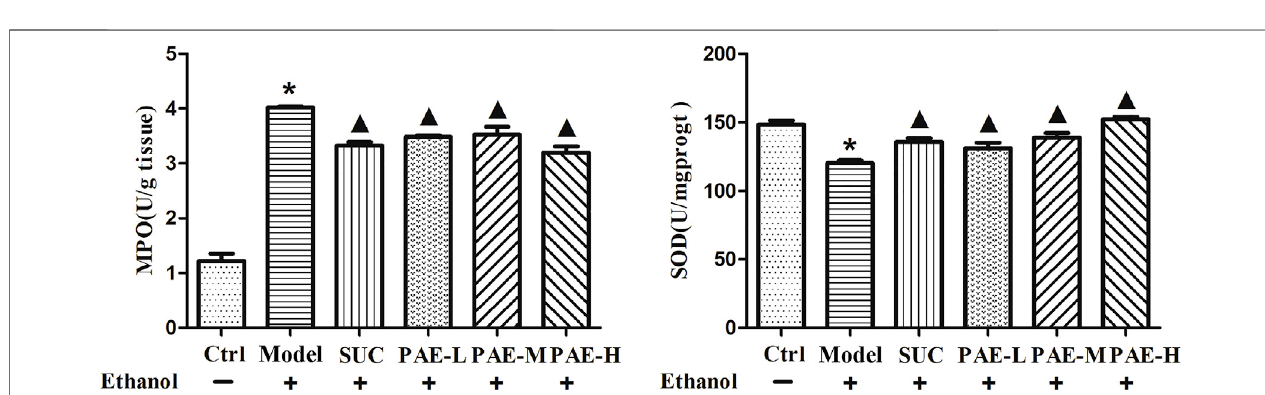
Frontiers in Pharmacology |